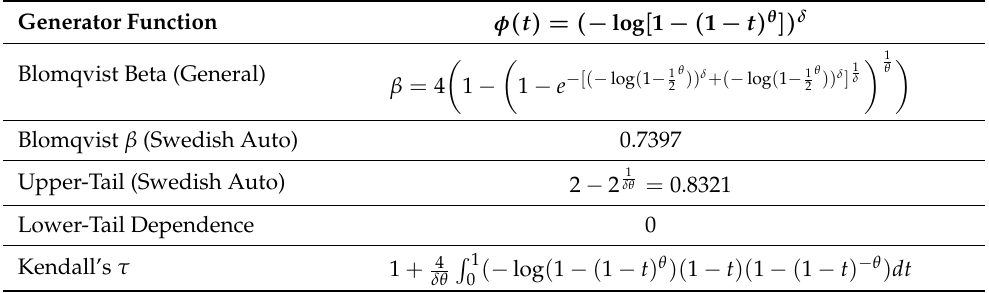
Table 5. Dependence structures of the BB6 copula for the Swedish motor insurance data. Generator